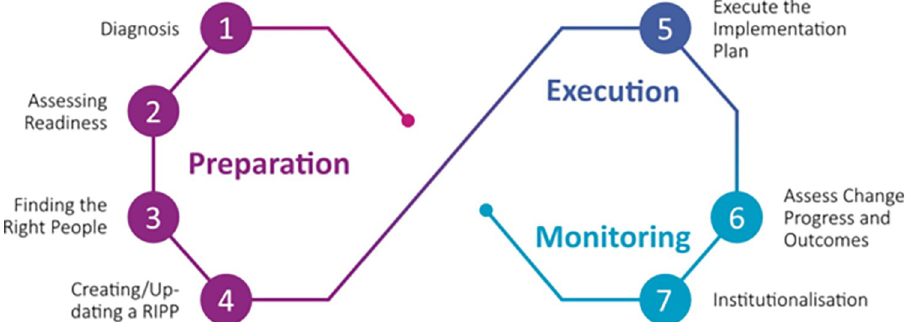
Fig 3. The implementation model. The model for RIPP implementation consists of 3 phases: Preparation, Execution, and Monitoring. Each of these phases involves tasks that are carried out in multiple steps. Importantly, the model proposes a cyclical format of creating, maintaining, and revising a culture of integrity. RIPP, Research Integrity Promotion Plan.